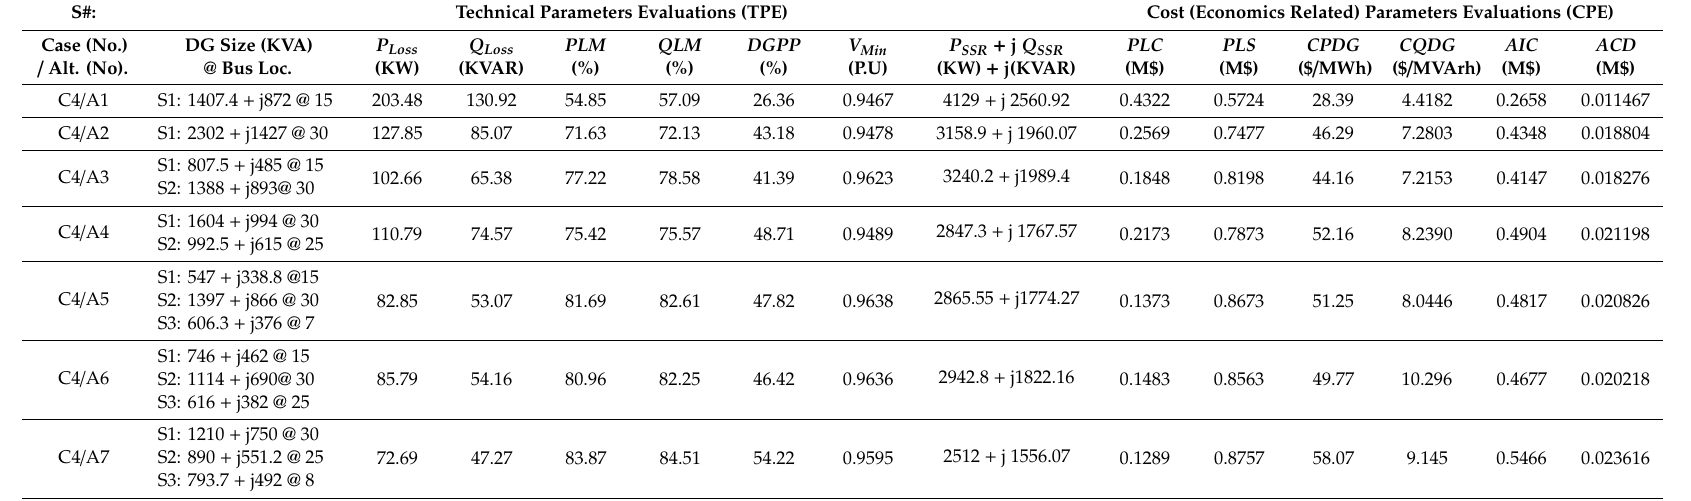
Table 19. Techno-economic evaluation analysis in case 4 (C4_LG) for 33-bus